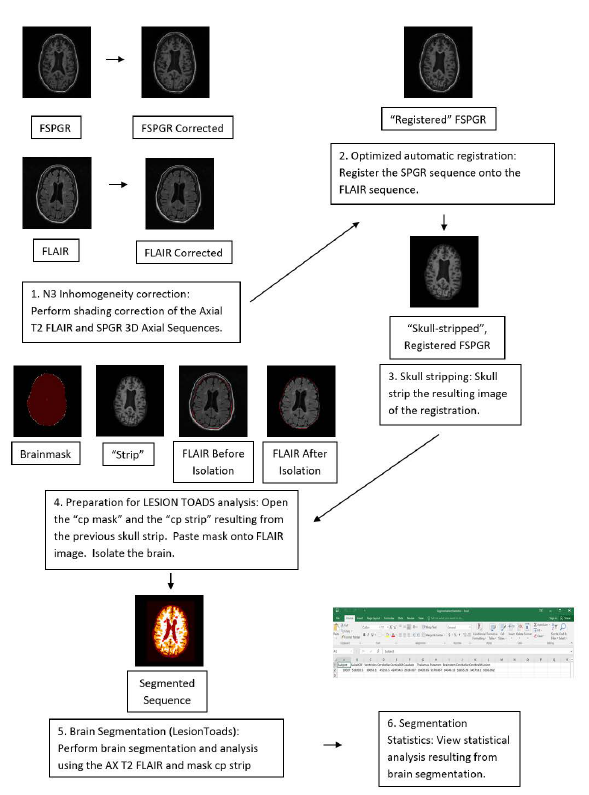
Figure 1. Software based Lesion Analysis “Work Flow”. Table 1. Patient Demographics: The study’s patient population consisted of males and females, Caucasians, Hispanic Americans, African Americans, and Asian Americans. The patients’ average age was approximately 40 years old. Patients of different demographic backgrounds were not equally distributed across presenting symptom groups. All Patients Visual Group Balance Group Sensory Group Motor